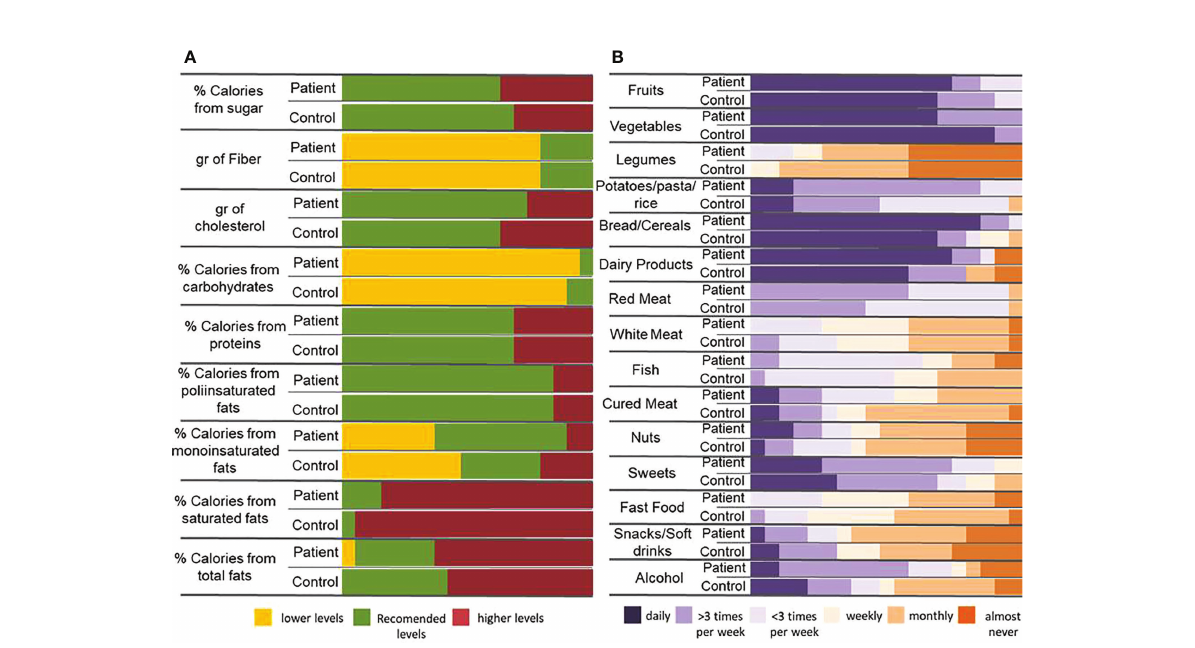
FIGURE 1 Dietary habits in patients and controls. (A) Percentage of calories provided by the main nutrients and contribution of some important components of the diet (cholesterol and fi ber) in patients and controls. The reference data used to carry out the analysis has been 25-35% of de total calories provided by fats (being saturate fats less than 7%, monounsaturated fats 15-20% and polyunsaturated fats no more than 9%), 10- 20% by proteins and 50-60% by carbohydrates. Sugars must not provide more than 10% of total calories and the consumption of less than 200g of cholesterol and between 20 and 35g of fi ber are recommended. (B) Frequency of food intake in patient and control